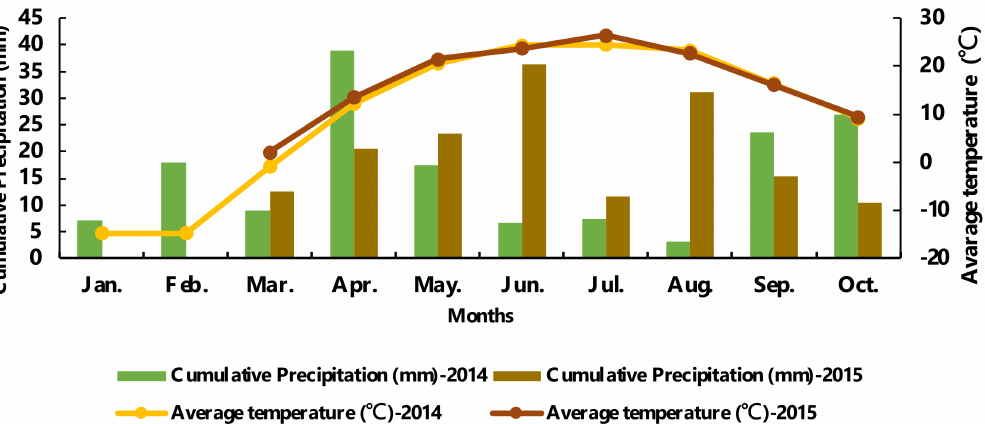
Figure 1. The average temperature and cumulative precipitation for each month in 2014 and 2015.